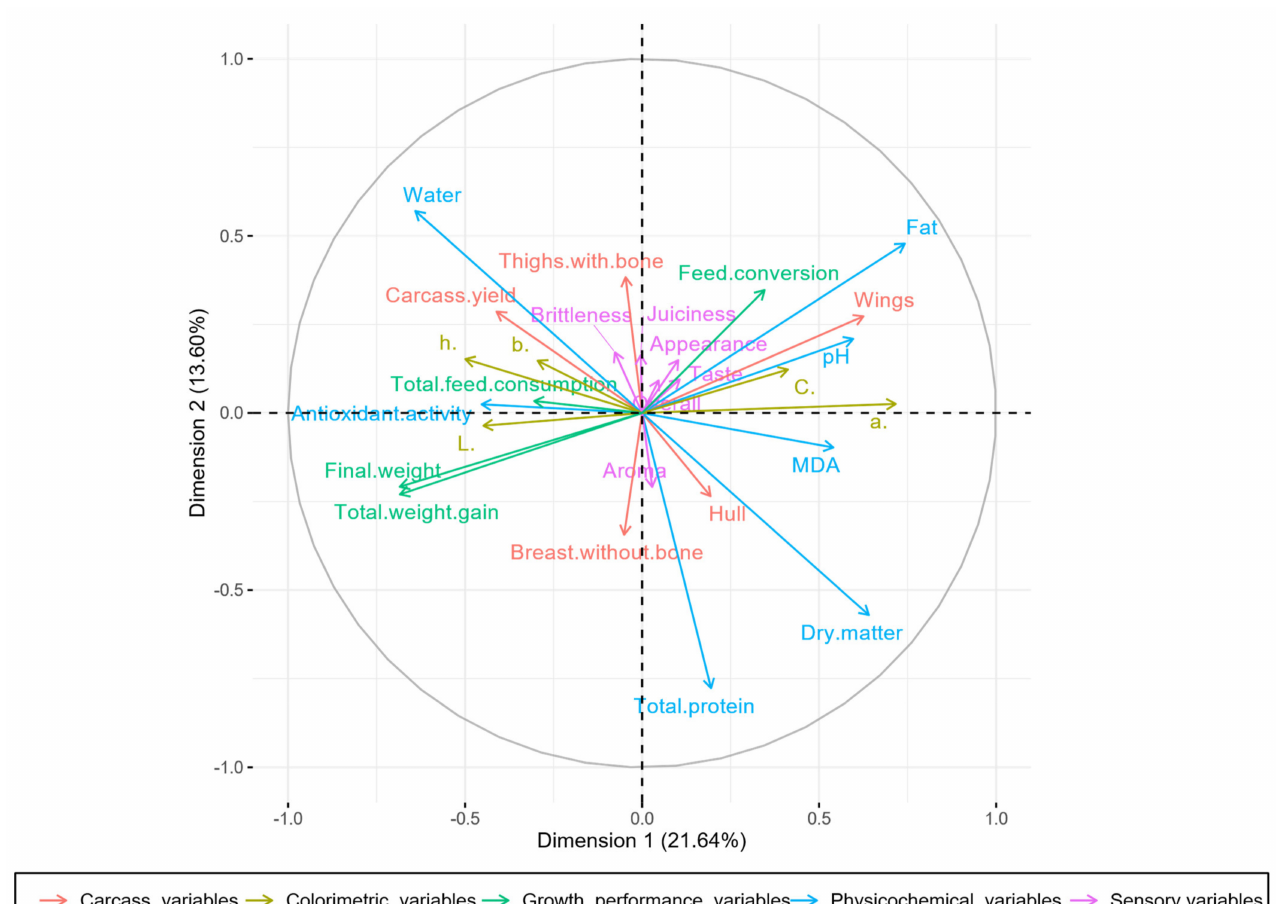
Figure 3. MFA plot of breast meat samples: correlation